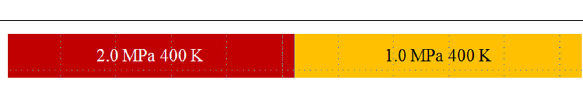
FIGURE 7 | The shock tube problem model.